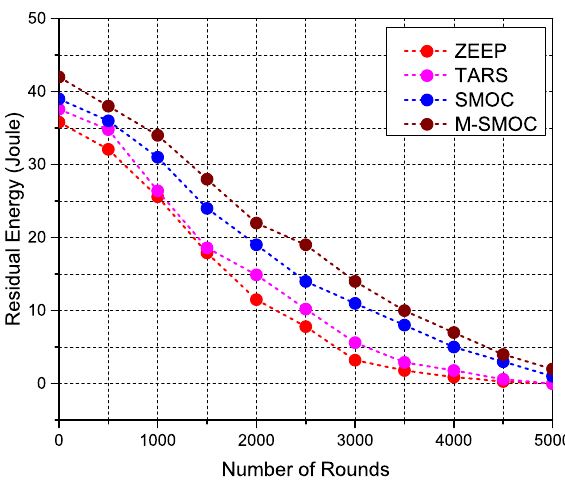
Figure 9. Comparison of the residual energy of sensor nodes with respect to the number of rounds.